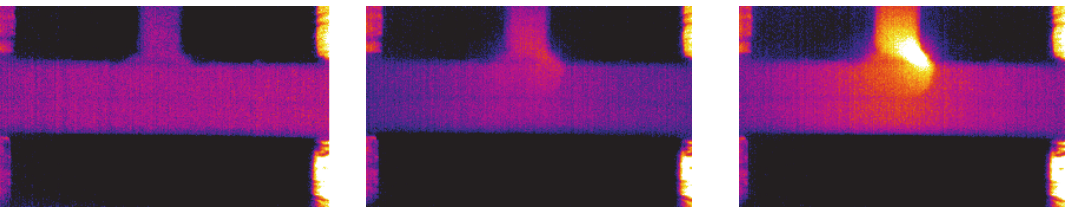
Figure 12: Thermal images during the test at 30 kN.